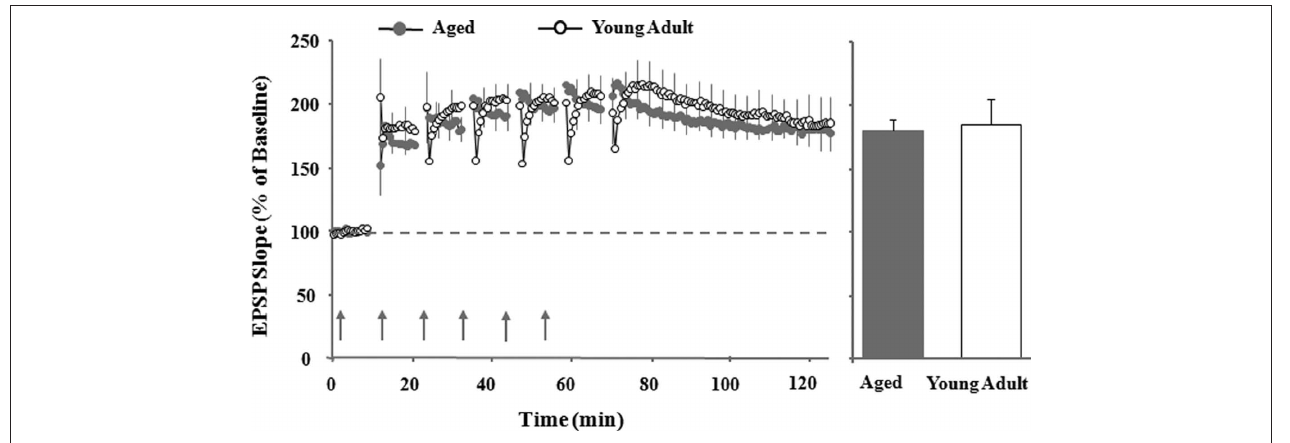
(60 min) the last episode of TBS. Bar diagram represents mean percentage change in the slope of synaptic responses during the last 10 min of recording, 60 min following the sixth TBS episode (adapted from Kumar et